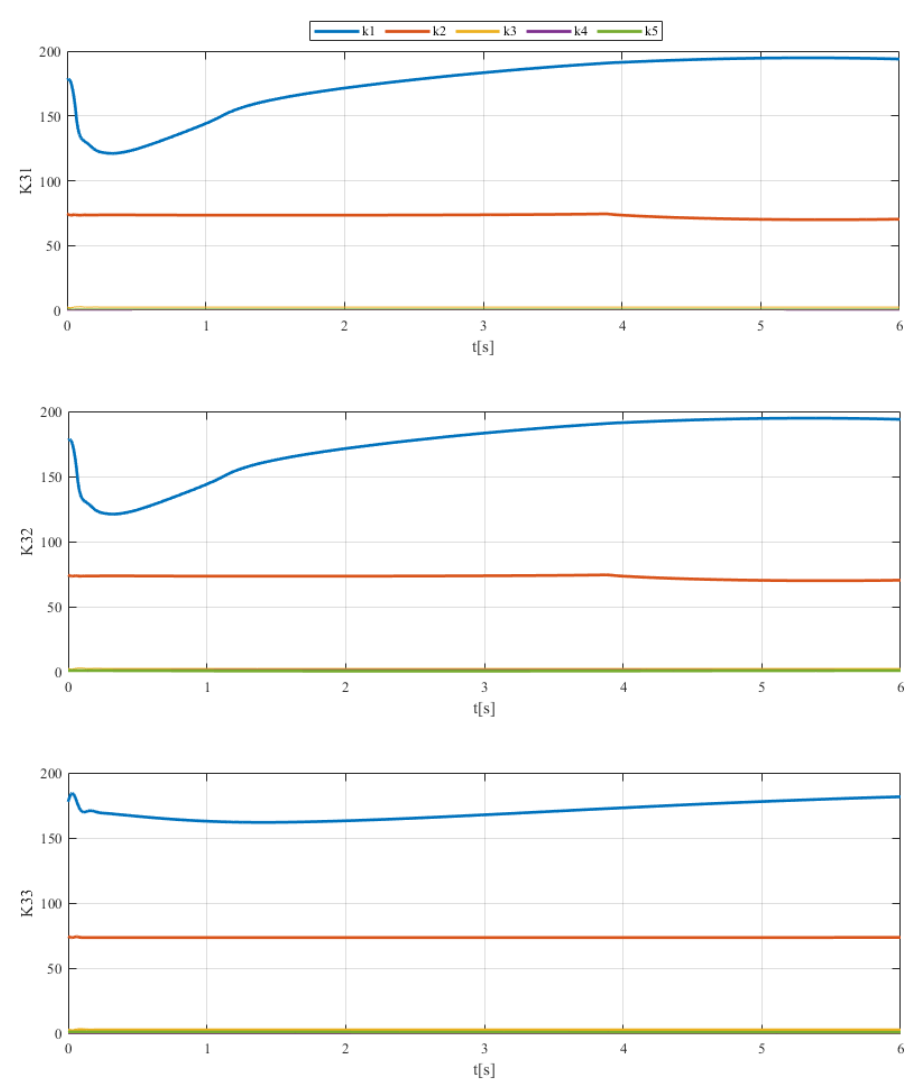
Figure 9. Controller gains of FLC for K31 (scenario 3, area 1), K32 (scenario 3, area 2), and K33 (scenario 3, area 3).